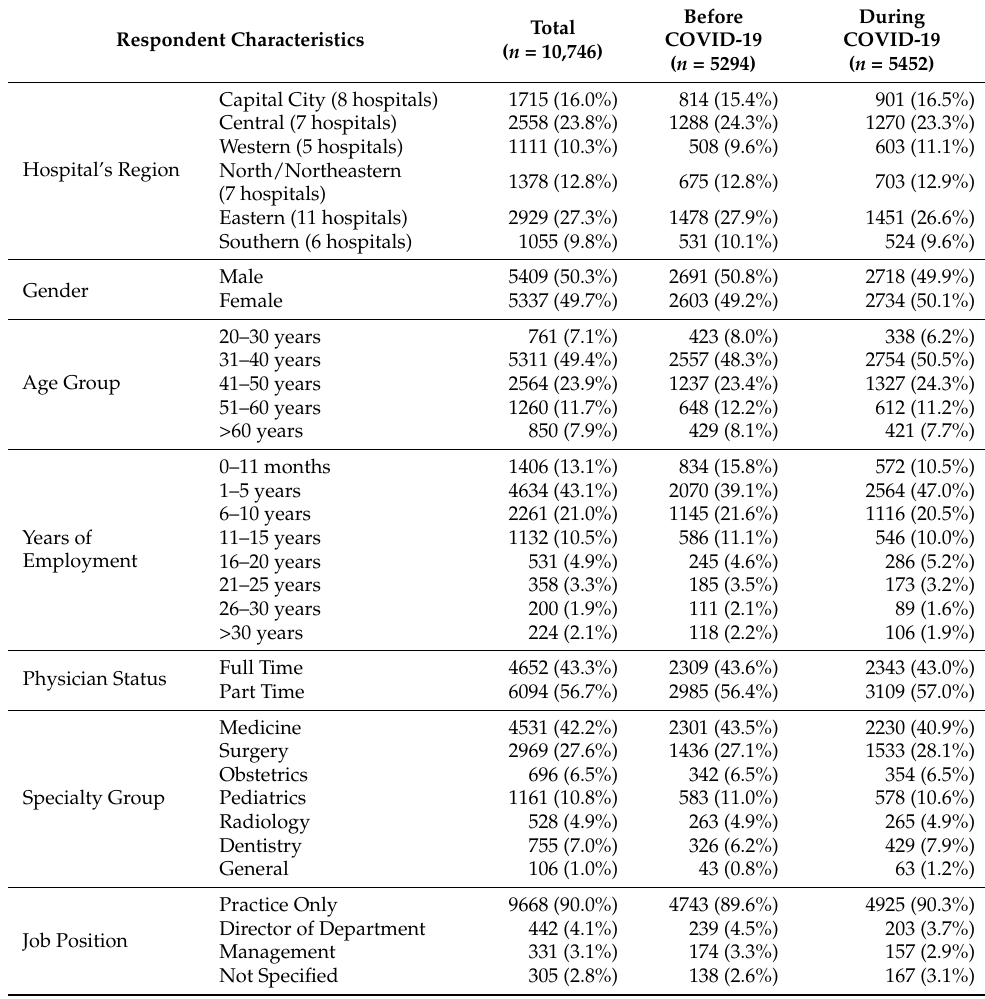
Table 1. The characteristics of medical/dental staff who responded to the engagement